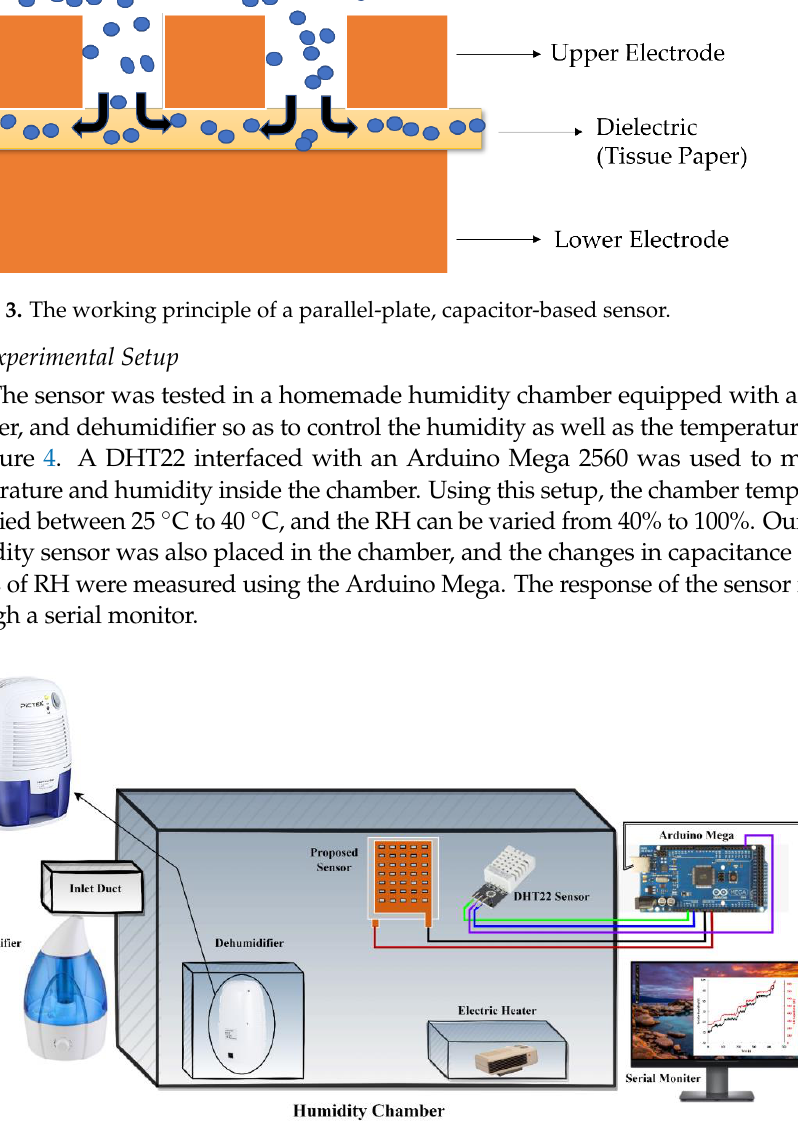
Figure 5. Change in %RH and capacitance of sensor as a function of time. 3. Results and Discussion The sensor has a capacitance of 240 pF at 45% RH. When RH is increased with the help of the humidifier, the capacitance increases along with it. Different values, such as 60%, 70%, 80%, 90%, and 100%, of RH were maintained inside the chamber, and the ca- pacitance values varied in accordance instantly. The measured values of the sensor’s ca- pacitance at different levels of RH are shown in Figure 6a. A linear trend exists between capacitance and RH, which can be used to determine RH from the sensor’s capacitance. Further, the sensor’s capacitance at any value of RH remains essentially unchanged if the humidity is increased up to that point or reduced from a higher value to that point, as indicated by the response and recovery times shown in Figure 6a. Figure 6b exhibits the transient response of the sensor, which was used to calculate the response and recovery times. Response time is defined as the time taken by the sensor to achieve 90% of total capacitance change during absorption, whereas recovery time is